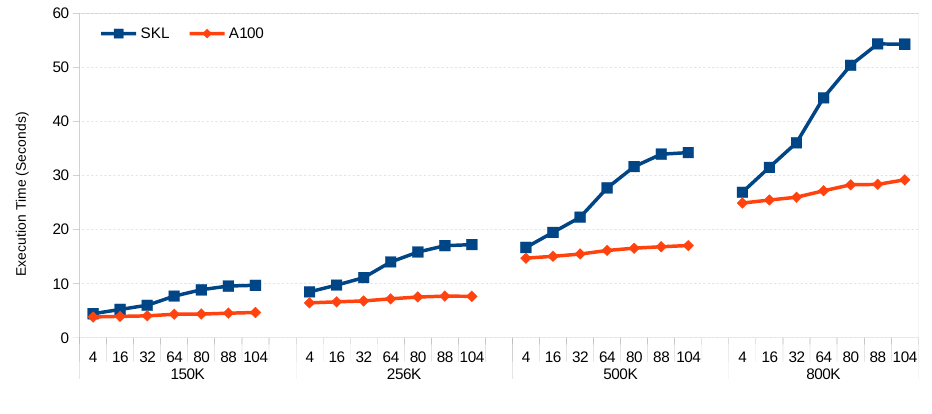
Figure 3. Execution time (seconds) for FCM.